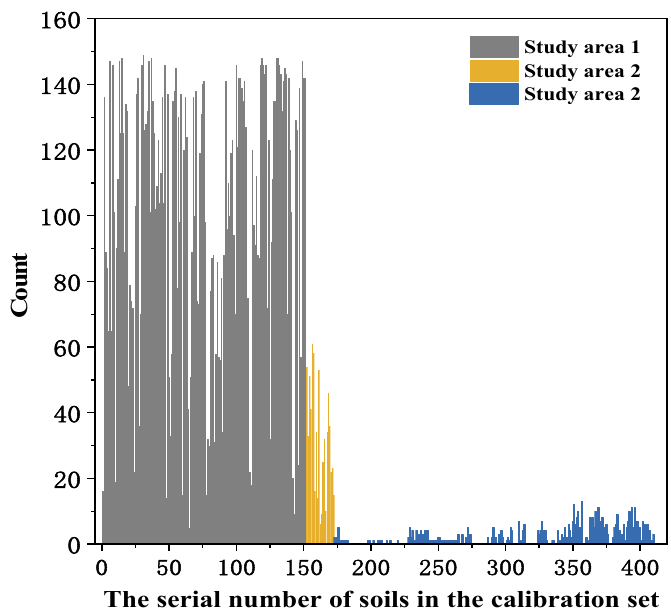
Figure 7. The frequency statistics of the selected samples according to SAM–PLSR. Study Area 2–1, the southeast section of Study Area 2; Study Area 2–2, the southwest section of Study Area